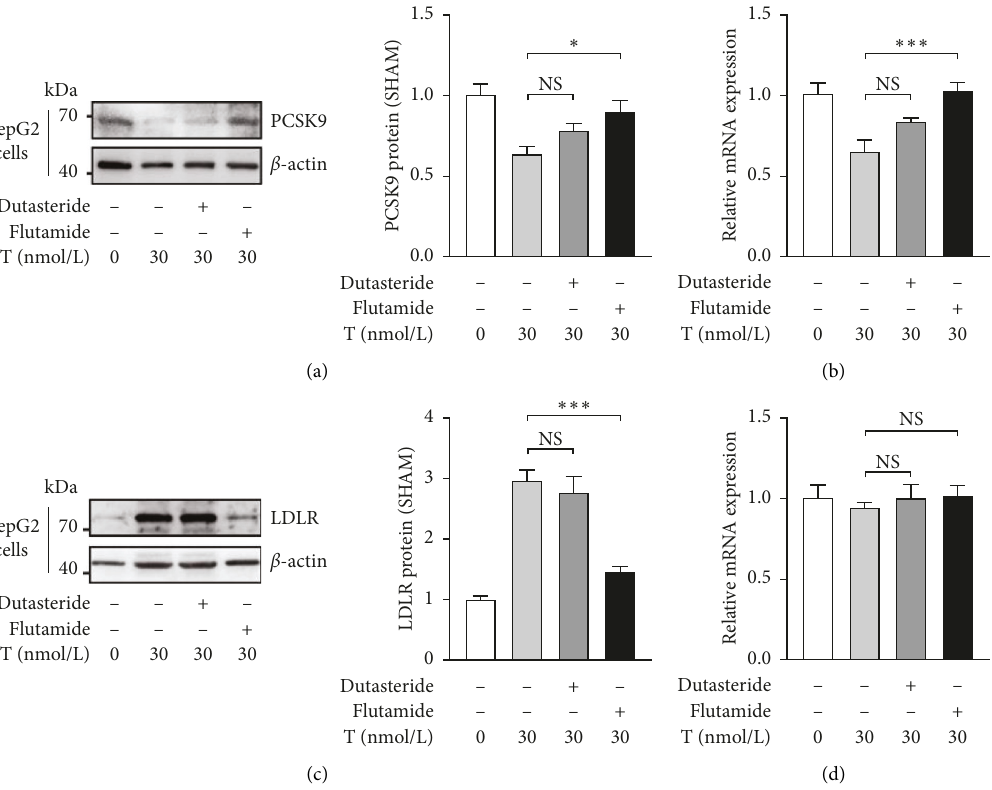
Figure 5: Androgen receptor (AR) antagonist flutamide abolishes the testosterone-induced PCSK9 downregulation and LDLR upregulation while 5 α reductase inhibitor dutasteride shows no effect. HepG2 cells were incubated with 0, 30nM testosterone for 72h or 30nM testosterone plus 50 μ M AR antagonist flutamide or 1.5 μ M 5 α reductase inhibitor dutasteride for 72h. Then cells were harvested. ((a), (b)) PCSK9 and ((c), (d)) LDLR were analyzed by western blotting or real-time quantitative PCR. Data are presented as mean analyses are one-way